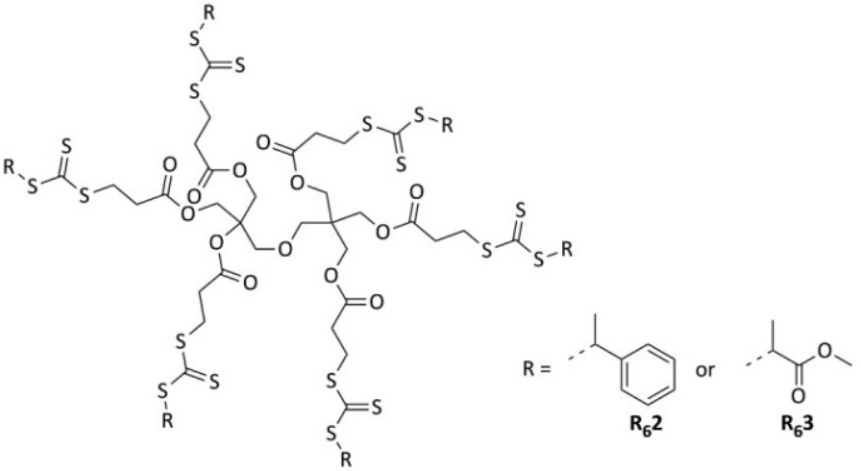
Figure 4. Dipentaerythriol-hexakis(3- S -phenylethyl-tricarbonylpropanoate) R acrylate (BA) and dipentaerythriol-hexakis(3- S -(methyl-2-propanoatotrithiocarbonyl)propanoate) 3 for N -isopropyl acrylamide (NIPAam) R 6